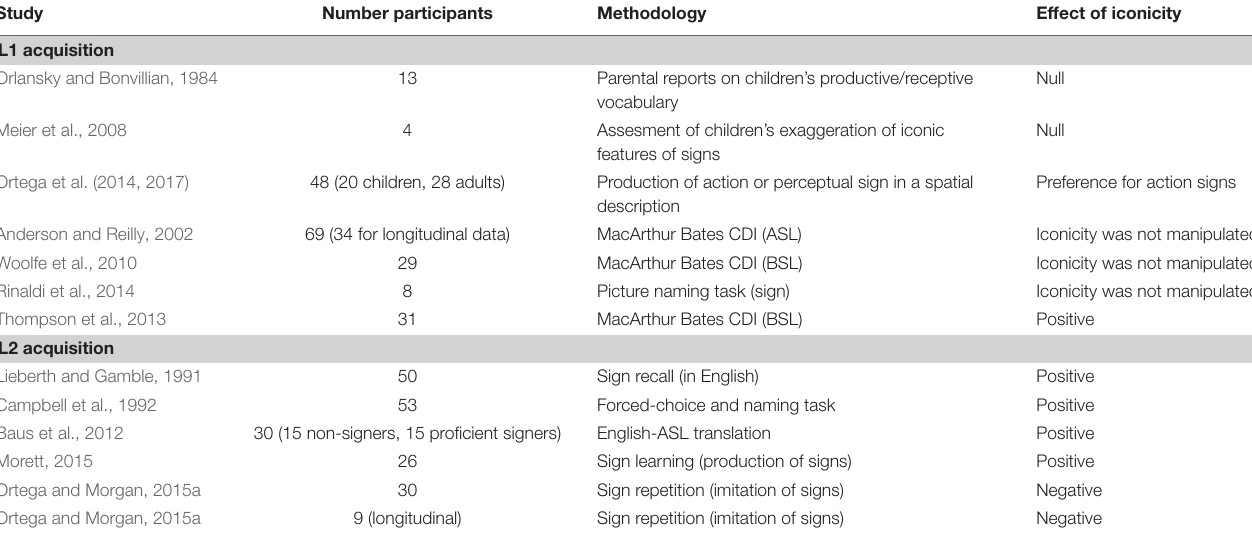
TABLE 1 | Summary of studies investigating the role of iconicity in sign L1 and L2